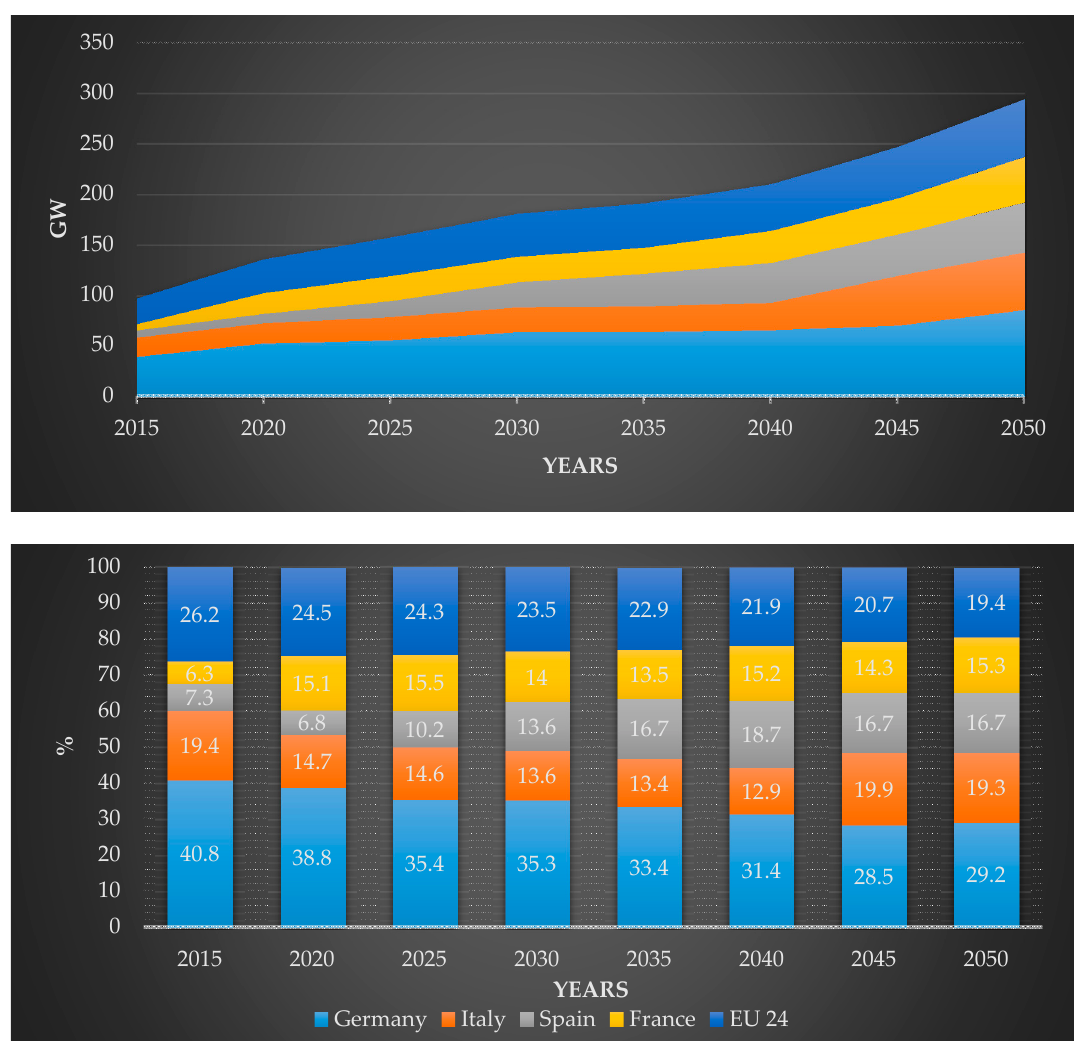
Figure 1. Net photovoltaic (PV) production capacity change based on EU Reference Scenario 2016 [15].